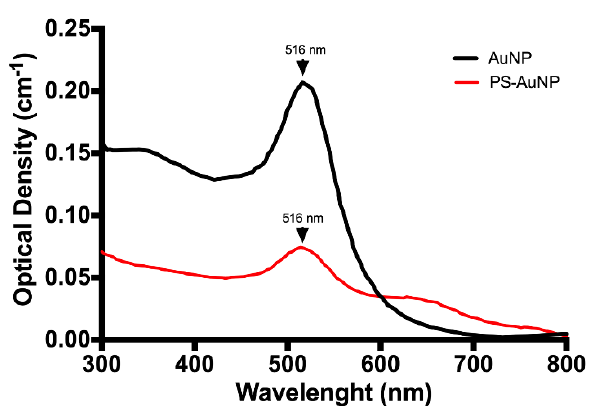
Figure 2. AuNP (Black line) and PS-AuNPs (Red line) characterization via surface plasmon resonance (SPR) effect.